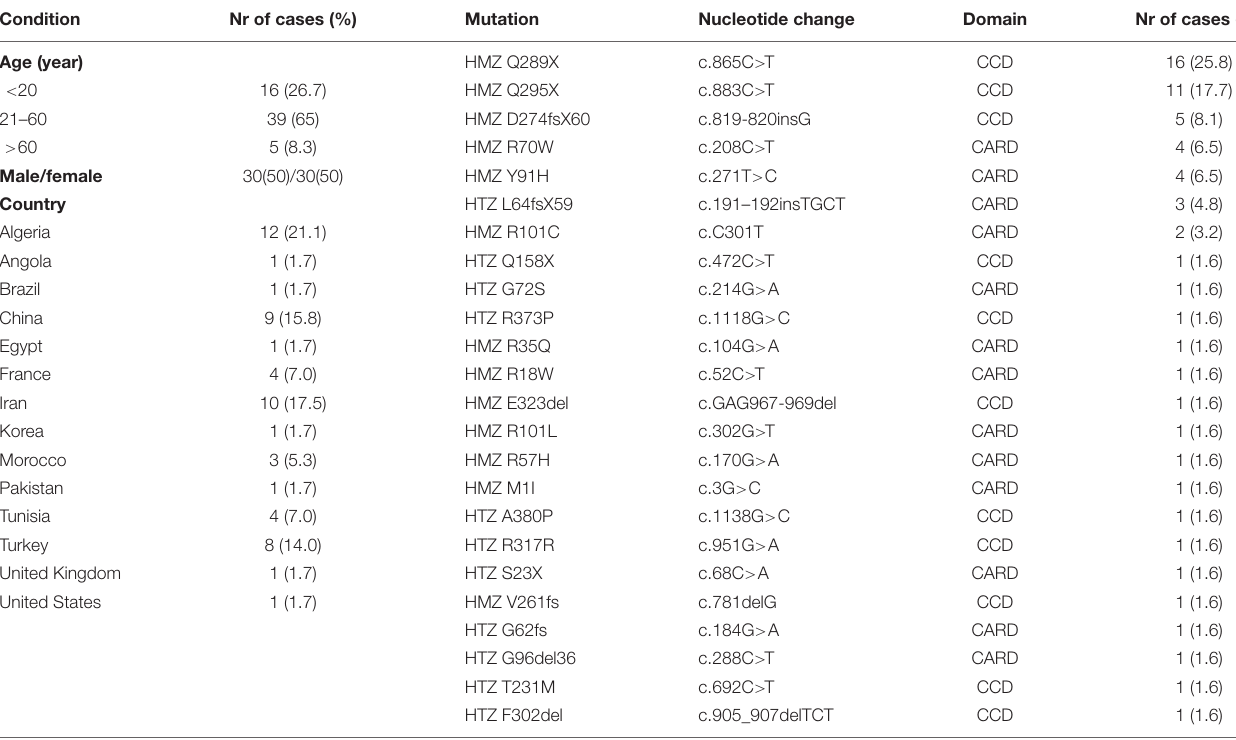
TABLE 1B | Overview of patient demographics and mutations.